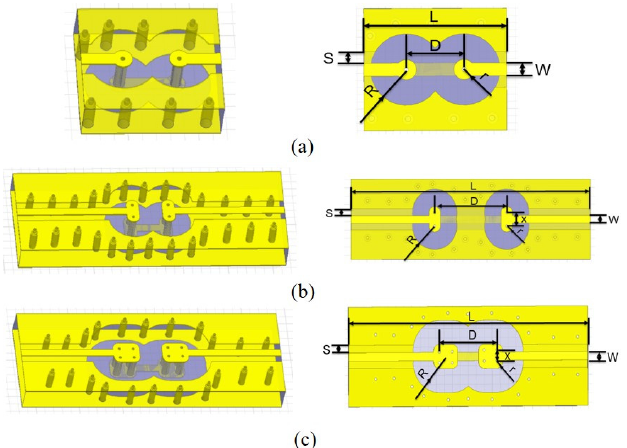
Figure 1. Test structure HFSS model: ( a ) single TSV; ( b ) dual redundant TSV; ( c ) quad redundant TSV. Table 1. Parameters of the test structure ( μ m).